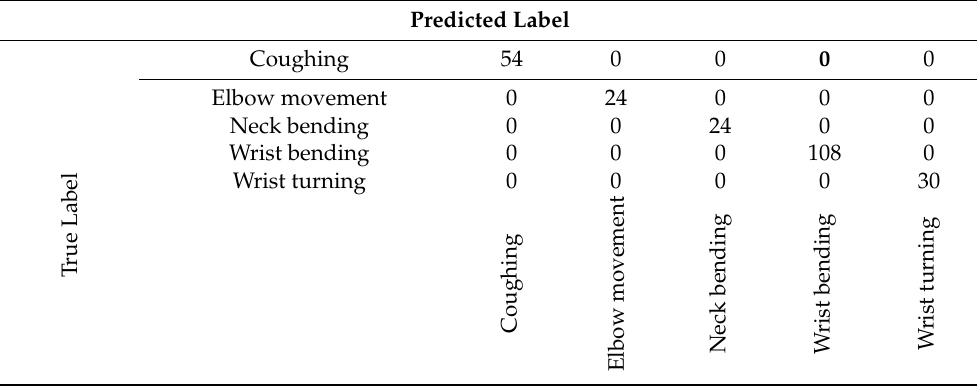
Table 8. Confusion matrix obtained with K-mer-based k-NN (number of cuts = 60 and subsequence length =